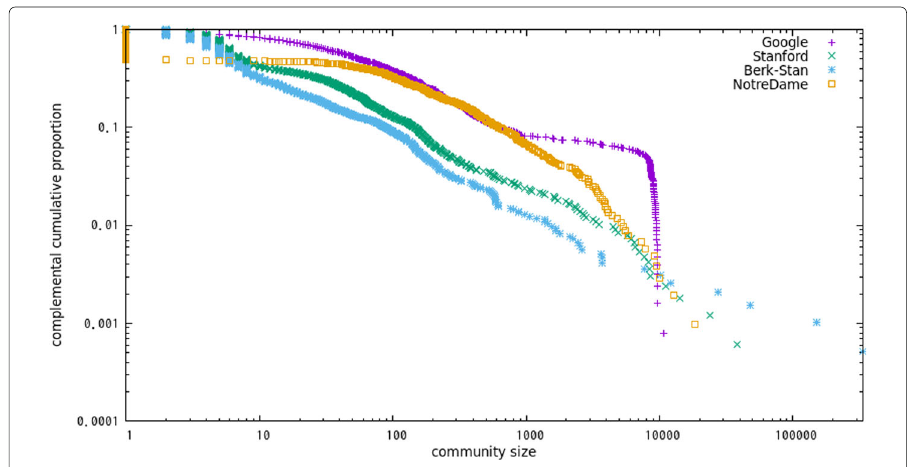
Fig. 10 web network community size distributions